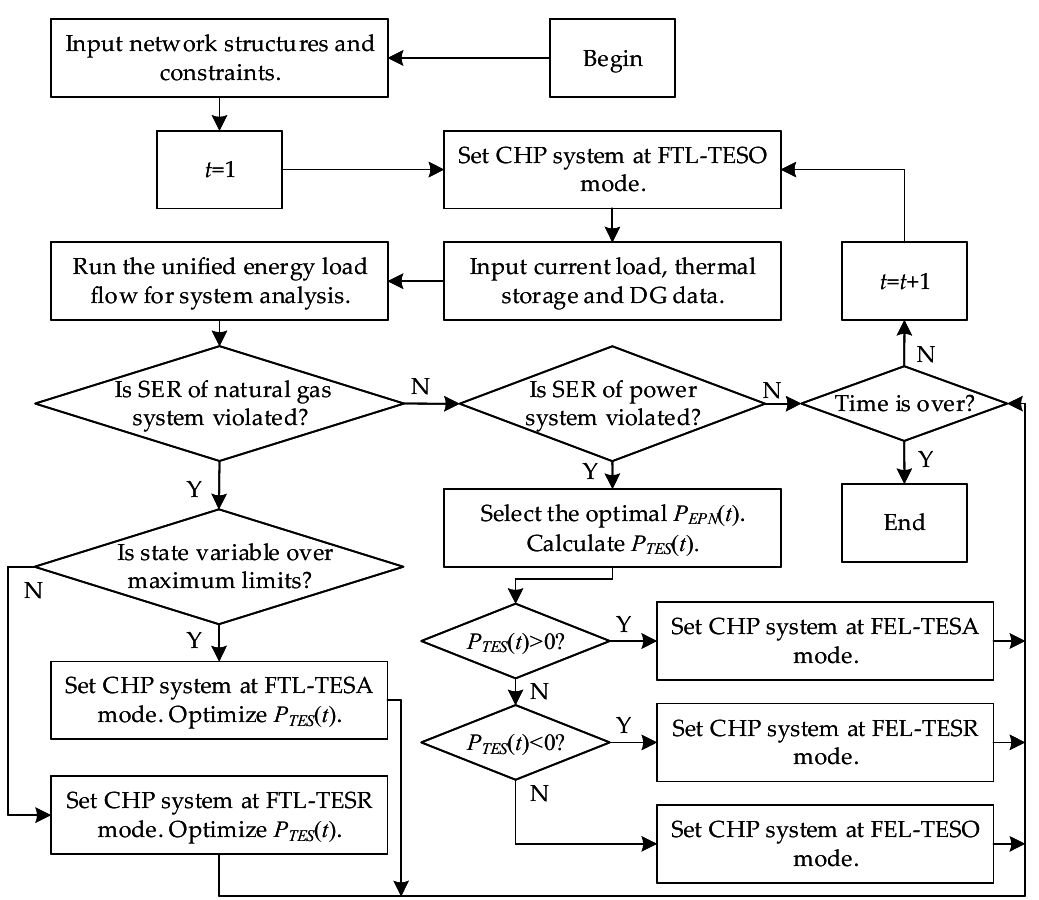
Figure 4. Coordinated operation and control strategy of hybrid energy system.